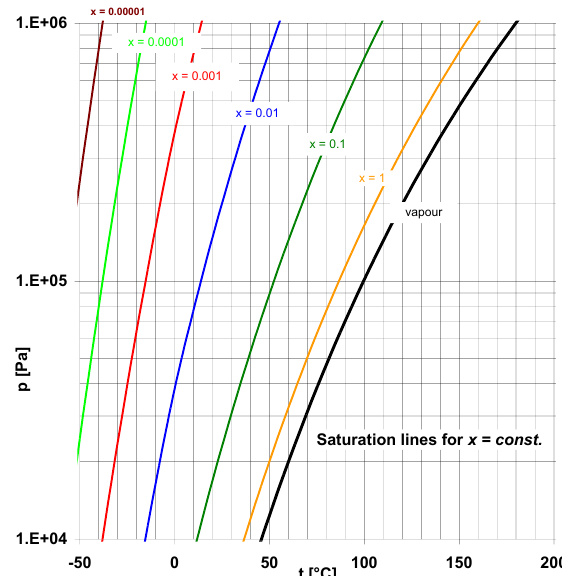
Fig. 2. Curves of saturated moist air for different values of specific moisture  